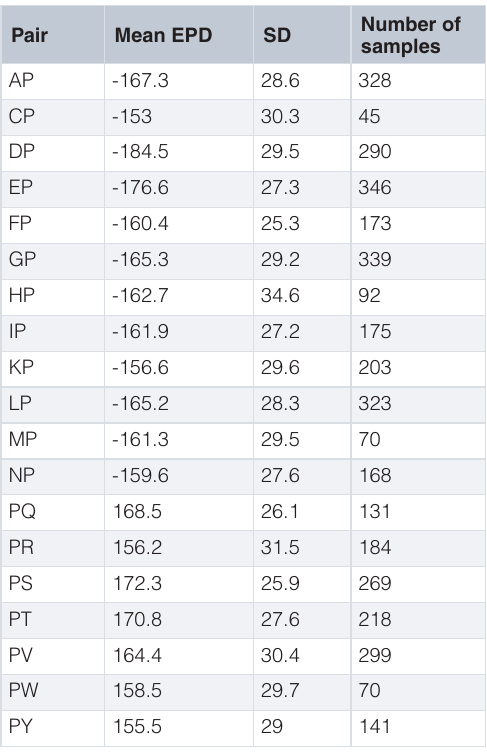
Table 1. Electrostatic potential differences (EPD) for consecutive residue pairs for C α atoms for residue pairs that include proline. While these pairs have for a low standard deviation (SD) like all other pairs, the absolute value of their mean is different (higher) than any pair that does not include a proline. This also highlights the unique nature of proline in protein